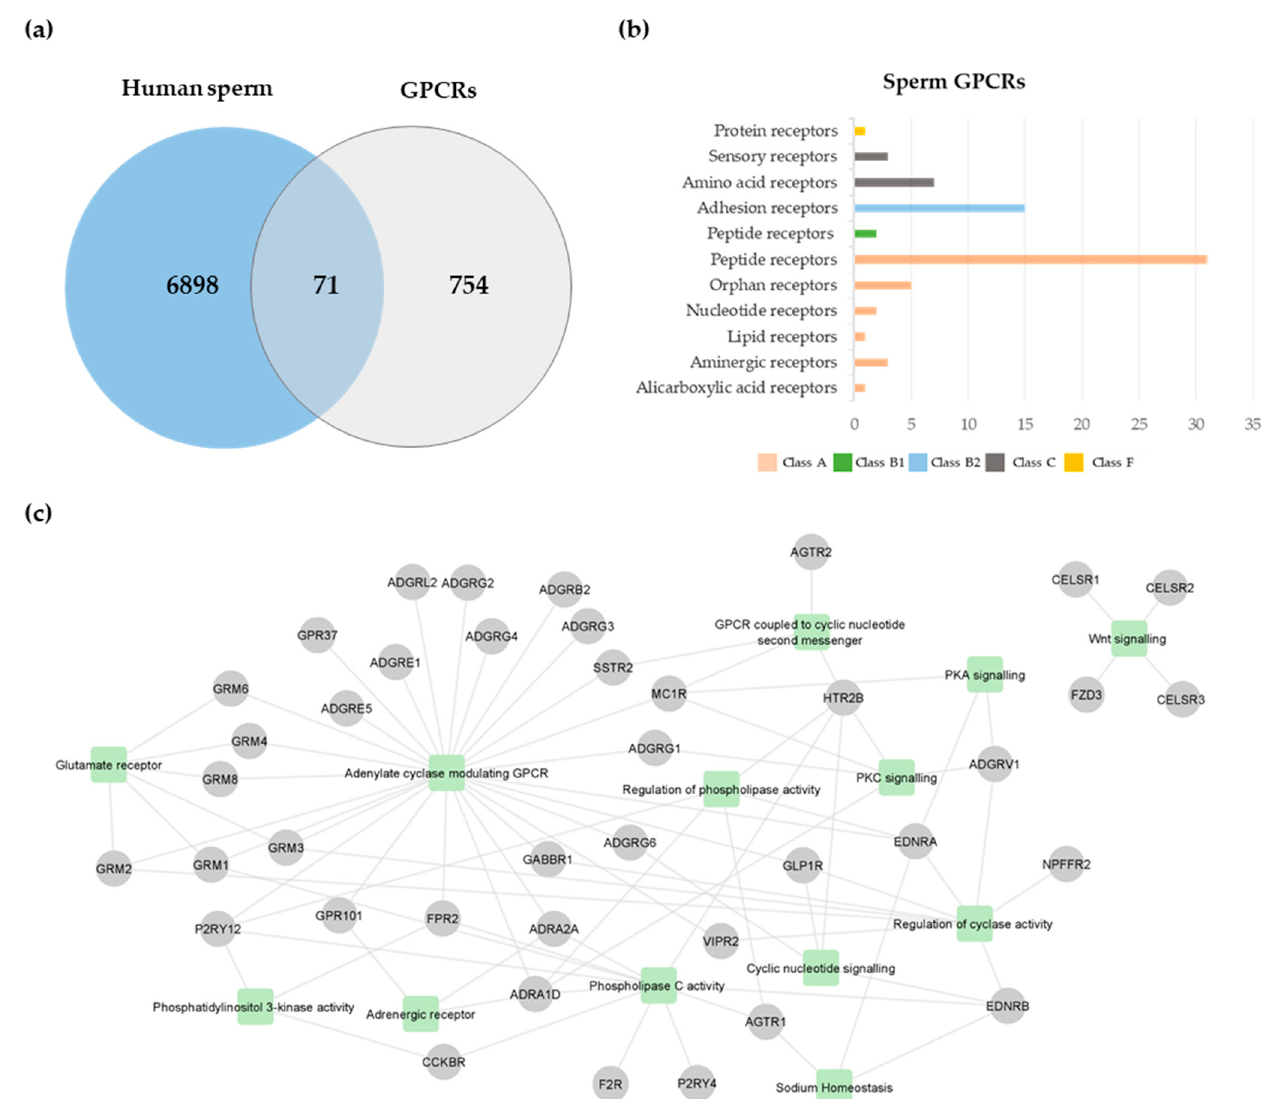
Figure 1. Sperm GPCRs. ( a ) Venn diagram illustrates the cross-comparison between the human sperm proteome and human GPCRs. For the subsequent analysis, only GPCRs identified in sperm were considered. ( b ) Classification of sperm GPCRs. ( c ) Integrative network of relevant processes associated with sperm GPCRs. Each node represents a GPCR (represented by gene name), and each square represents a class of biological processes.